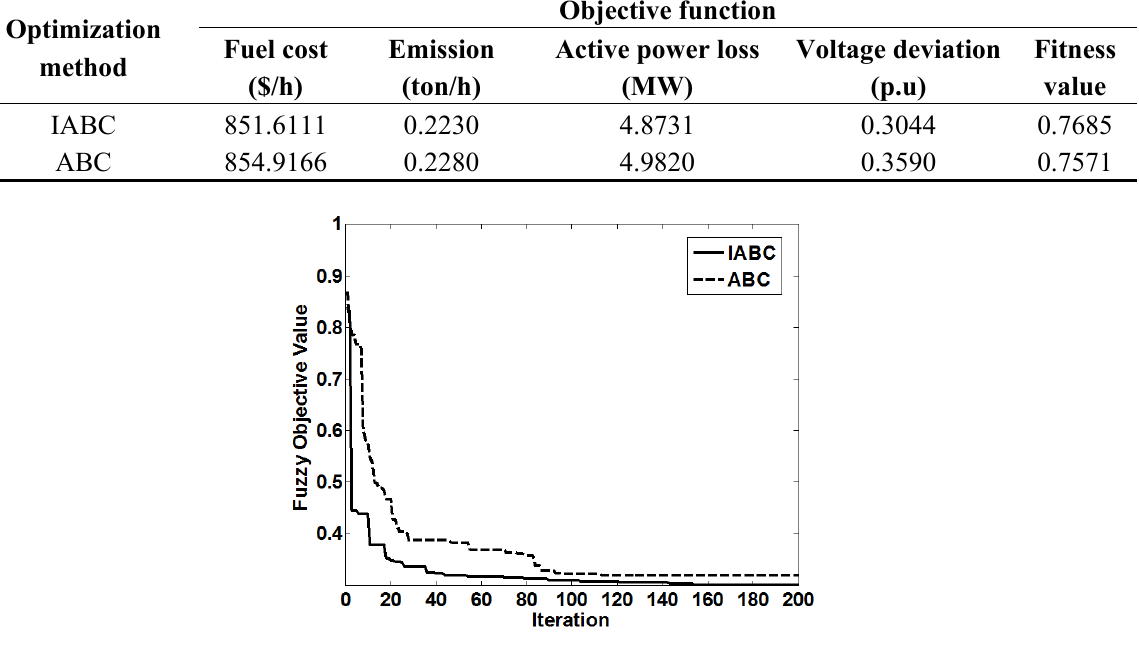
Figure 11. Multi-objective convergence characteristic curves of the IABC and ABC algorithms for the IEEE 30-bus